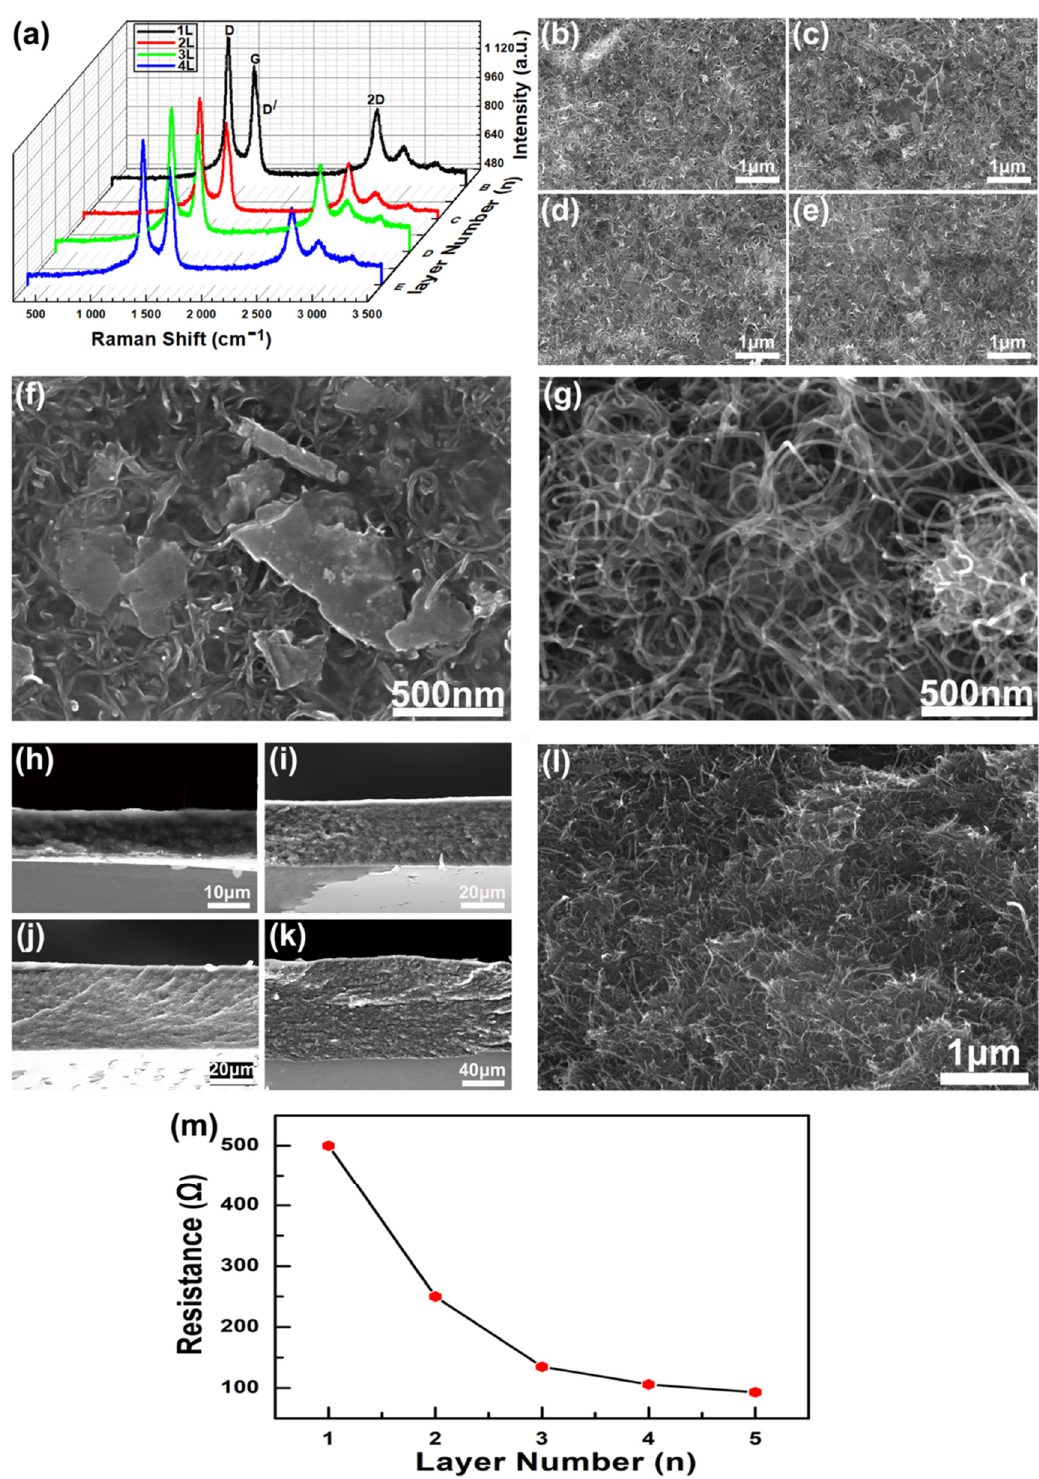
Figure 2. Characterization of graphene/CNTs conductive coating. ( a ) Raman spectra of graphene/carbon nanotube conductive coatings with different layers, respectively. ( b – e ) SEM image of 1~4-layer graphene/CNTs conductive coating surface. ( f ) SEM image of sheet-like multilayer graphene on conductive coating. ( g ) SEM image of multi-walled carbon nanotubes on conductive coating. ( h – k ) SEM side view of 1–4 layer graphene/CNTs conductive coating. ( l ) High magnification SEM side view of the conductive coating. ( m ) Relationship between the number of conductive coating layers and the resistance value of conductive